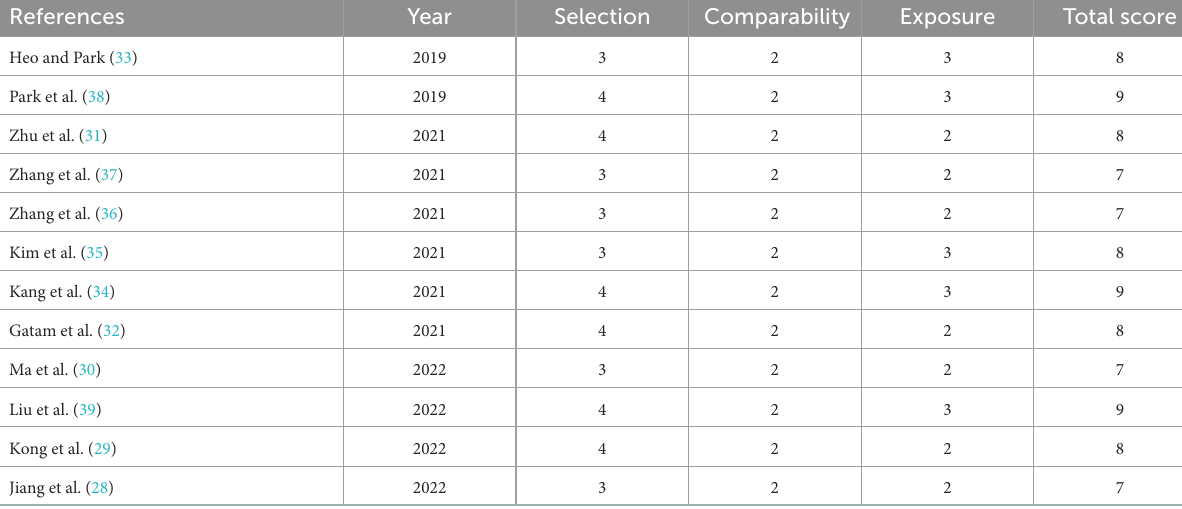
TABLE 1 Quality assessment of studies according to Newcastle-Ottawa Scale